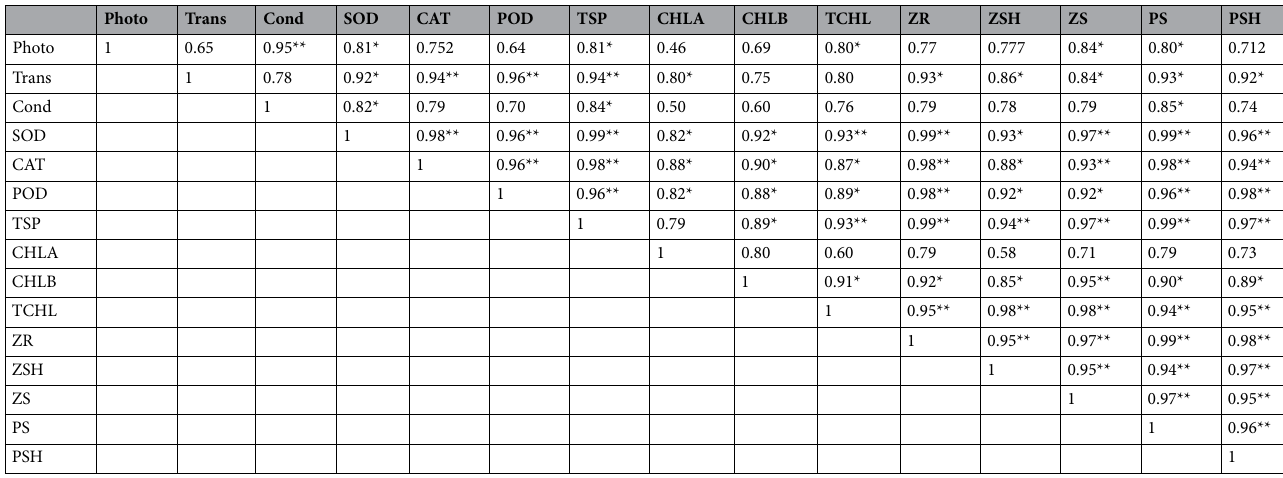
Table 1. Pearson’s correlation coefficients between the variables under zinc-deficient soil conditions. **Highly significant ( p < 0.01), *significant ( p < 0.05). Photo, photosynthetic rate; Trans, transpiration rate; Cond, stomatal conductance; SOD, superoxide dismutase; CAT, catalase; POD, peroxidase; TSP, total soluble protein; CHLA, chlorophyll a; CHLB, chlorophyll b; TCHL, total chlorophyll; ZR, zinc in roots; ZSH, zinc in shoot; ZS, zinc in soil; PS, phosphorus in soil; PSH, phosphorus in shoot.